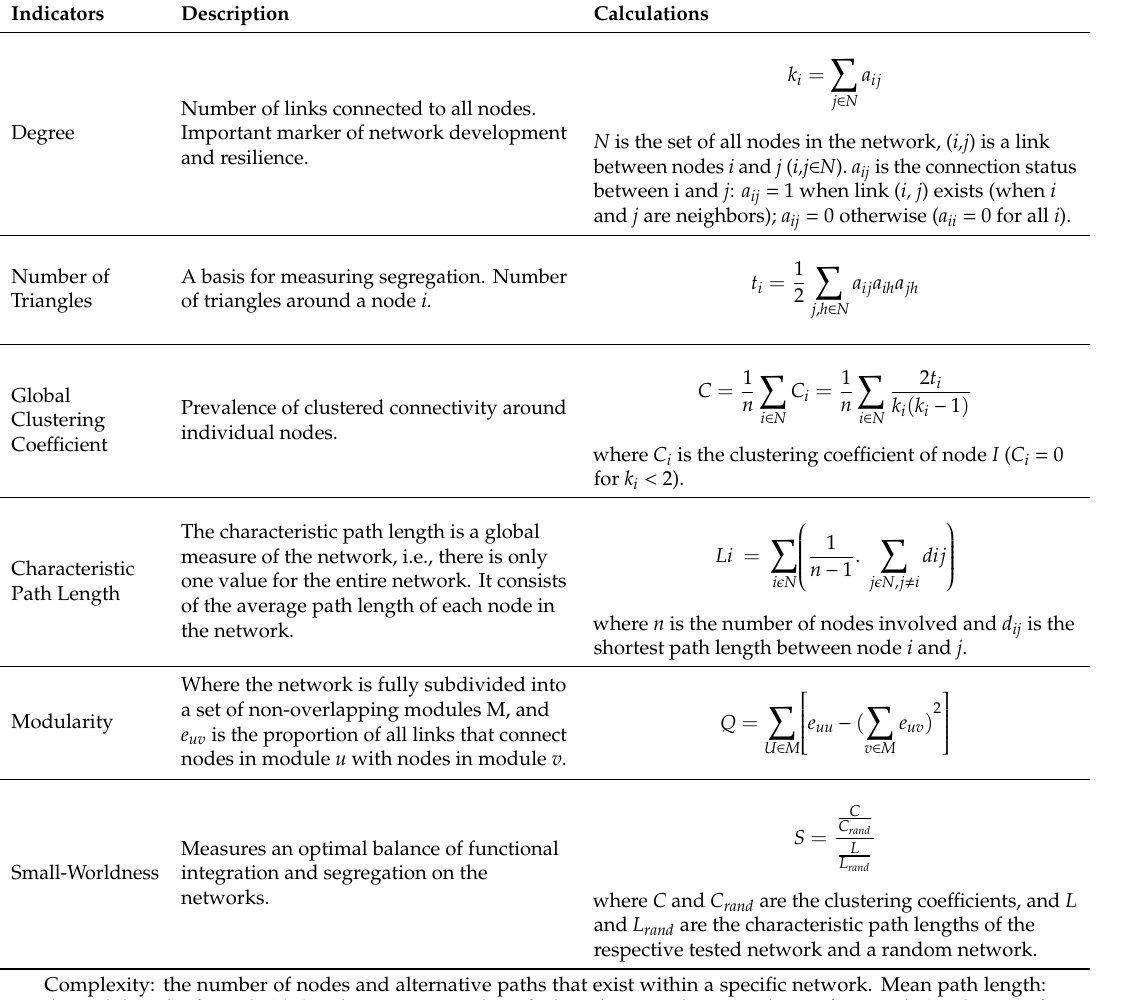
Table 2. Complex network indicators used in the